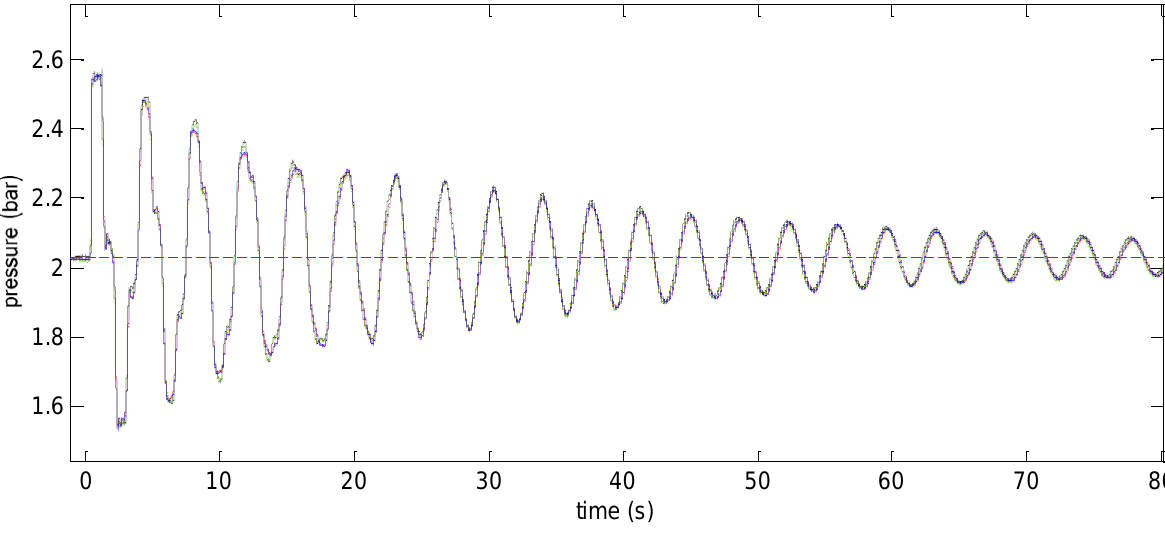
Fig 10. Pressure measured by transducer p